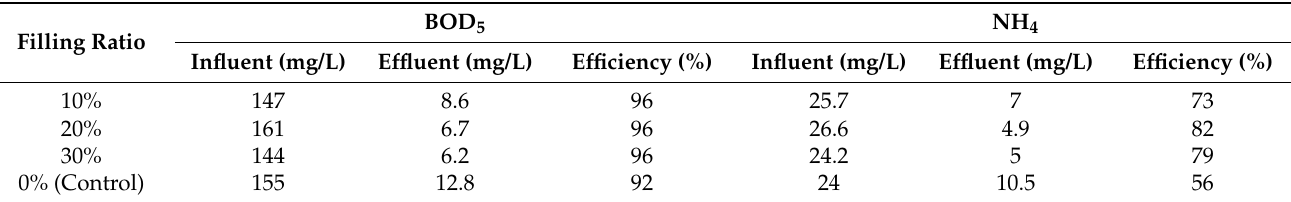
Table 3. Average values of treatment for